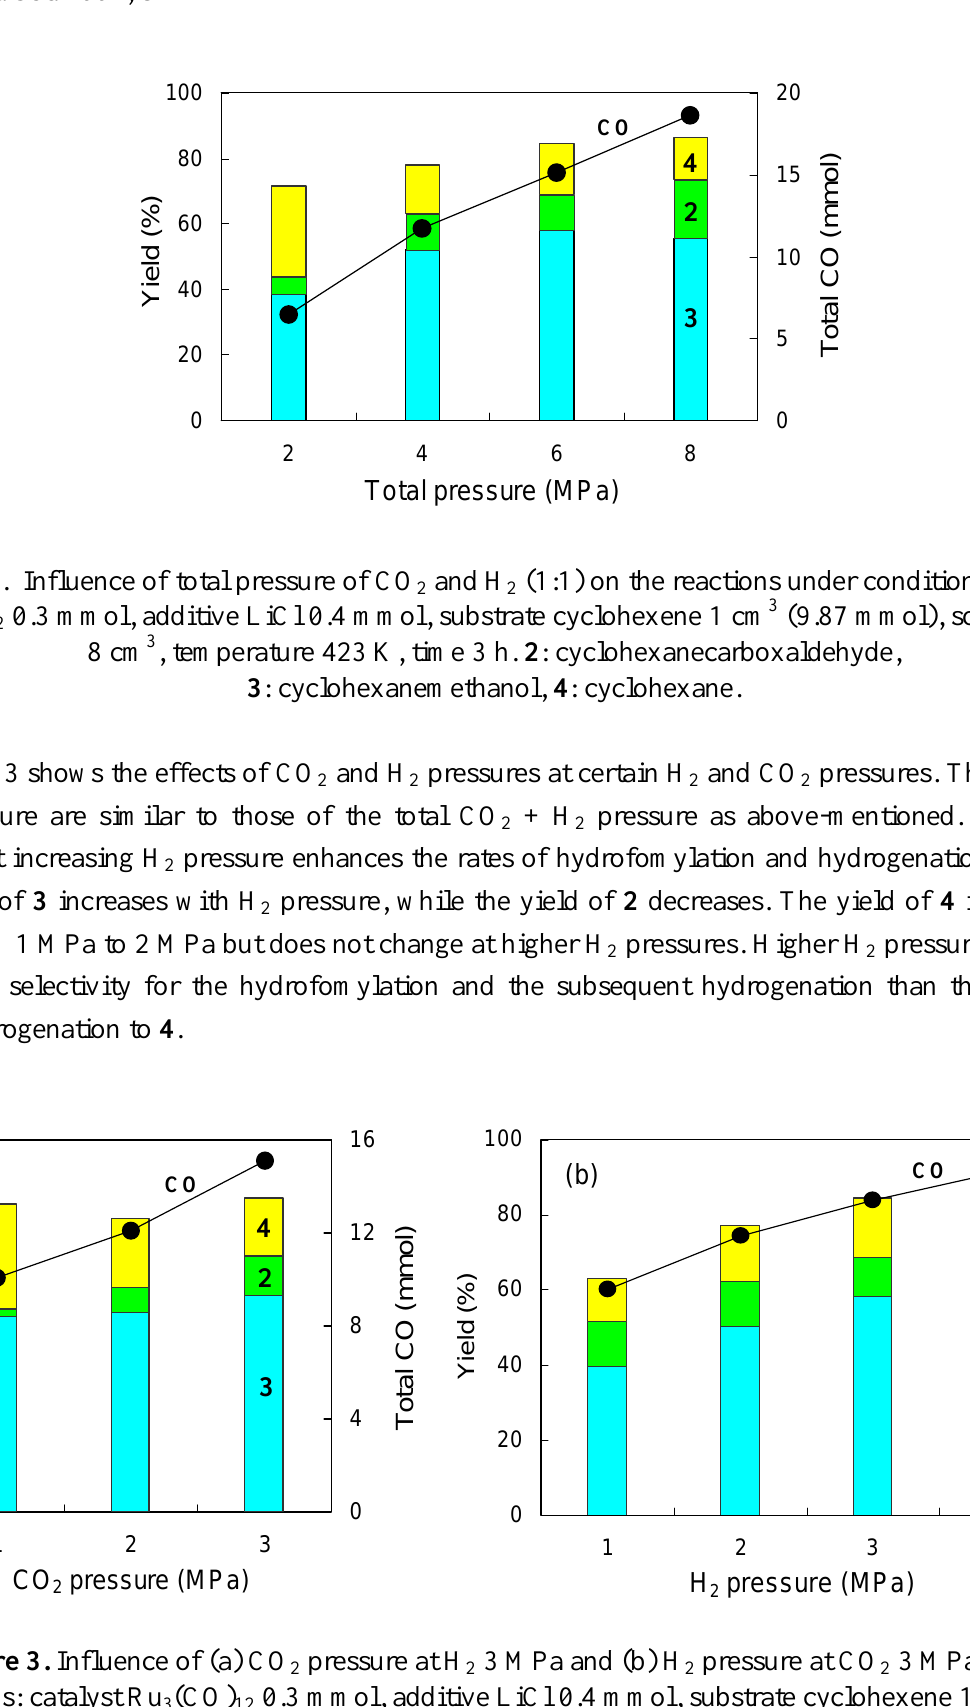
pressure at H 3 MPa and (b) H pressure at CO 3 MPa under Figure 3. Influence of (a) CO 2 2 2 2 conditions: catalyst Ru (CO) 0.3 mmol, additive LiCl 0.4 mmol, substrate cyclohexene 1 cm 3 (9.87 3 12 mmol), solvent NMP 8 cm 3 , temperature 423 K, time 3 h. 2 : cyclohexanecarboxaldehyde, 3 : cyclohexanemethanol, 4 :